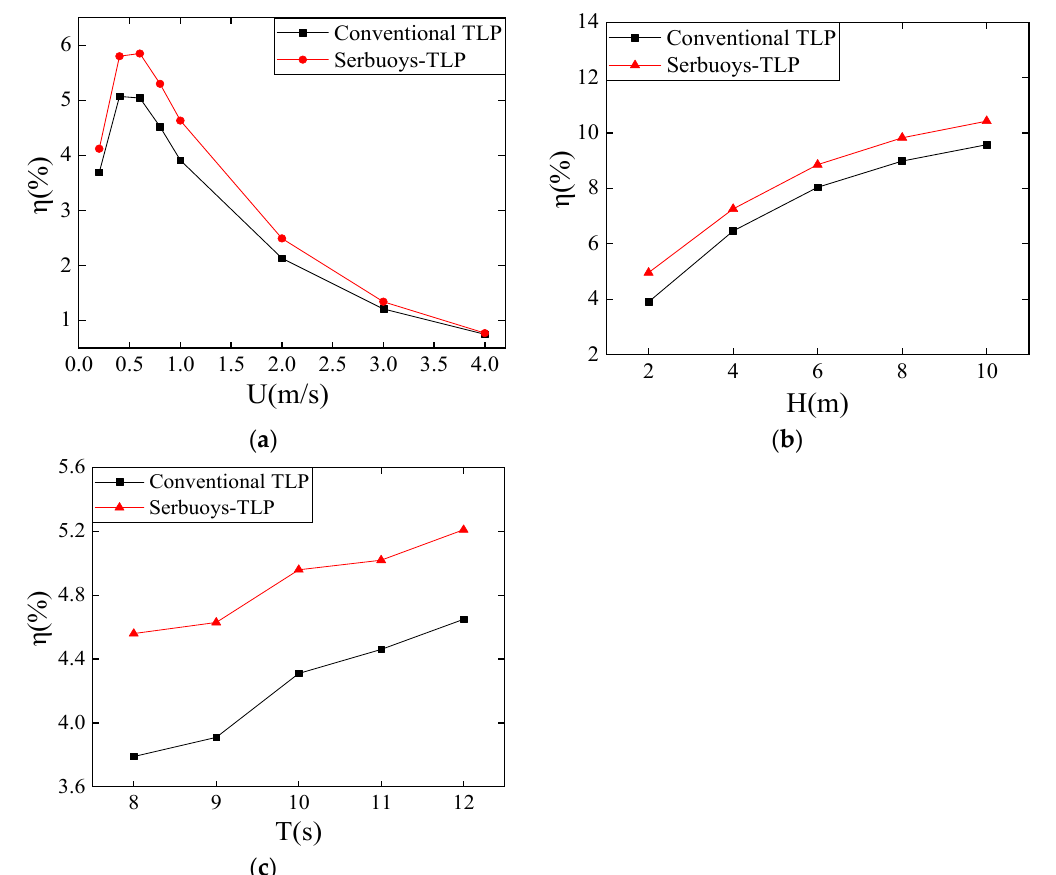
Figure 13. Effect of whether the waves and currents are coupled on the surge of a TLP. ( a ) The effect of current velocity on η ; ( b ) the effect of wave height on η ; ( c ) the effect of wave period on η .